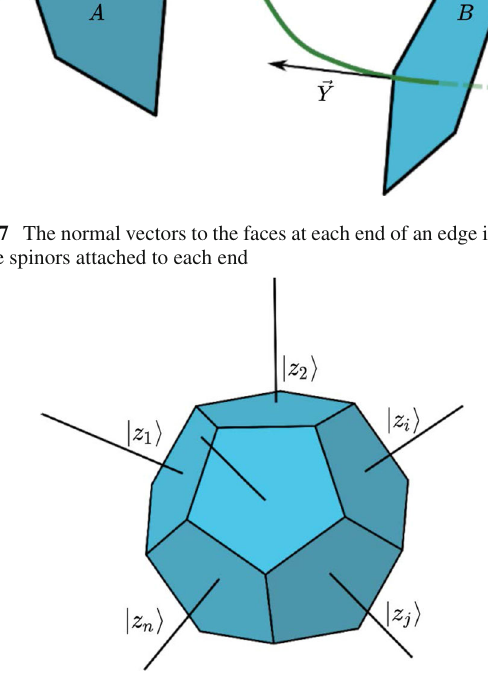
Fig. 8 The classical phase space of an intertwiner. Each leg is labelled by a spinor | z i (cid:5) ∈ C 2 where i ∈ { 1 ,..., n } for which (cid:16) X (cid:16) = 0, (cid:4) z | z (cid:5) = 0, (cid:4)˜ z |˜ z (cid:5) = 0 are excluded from both sides of the above